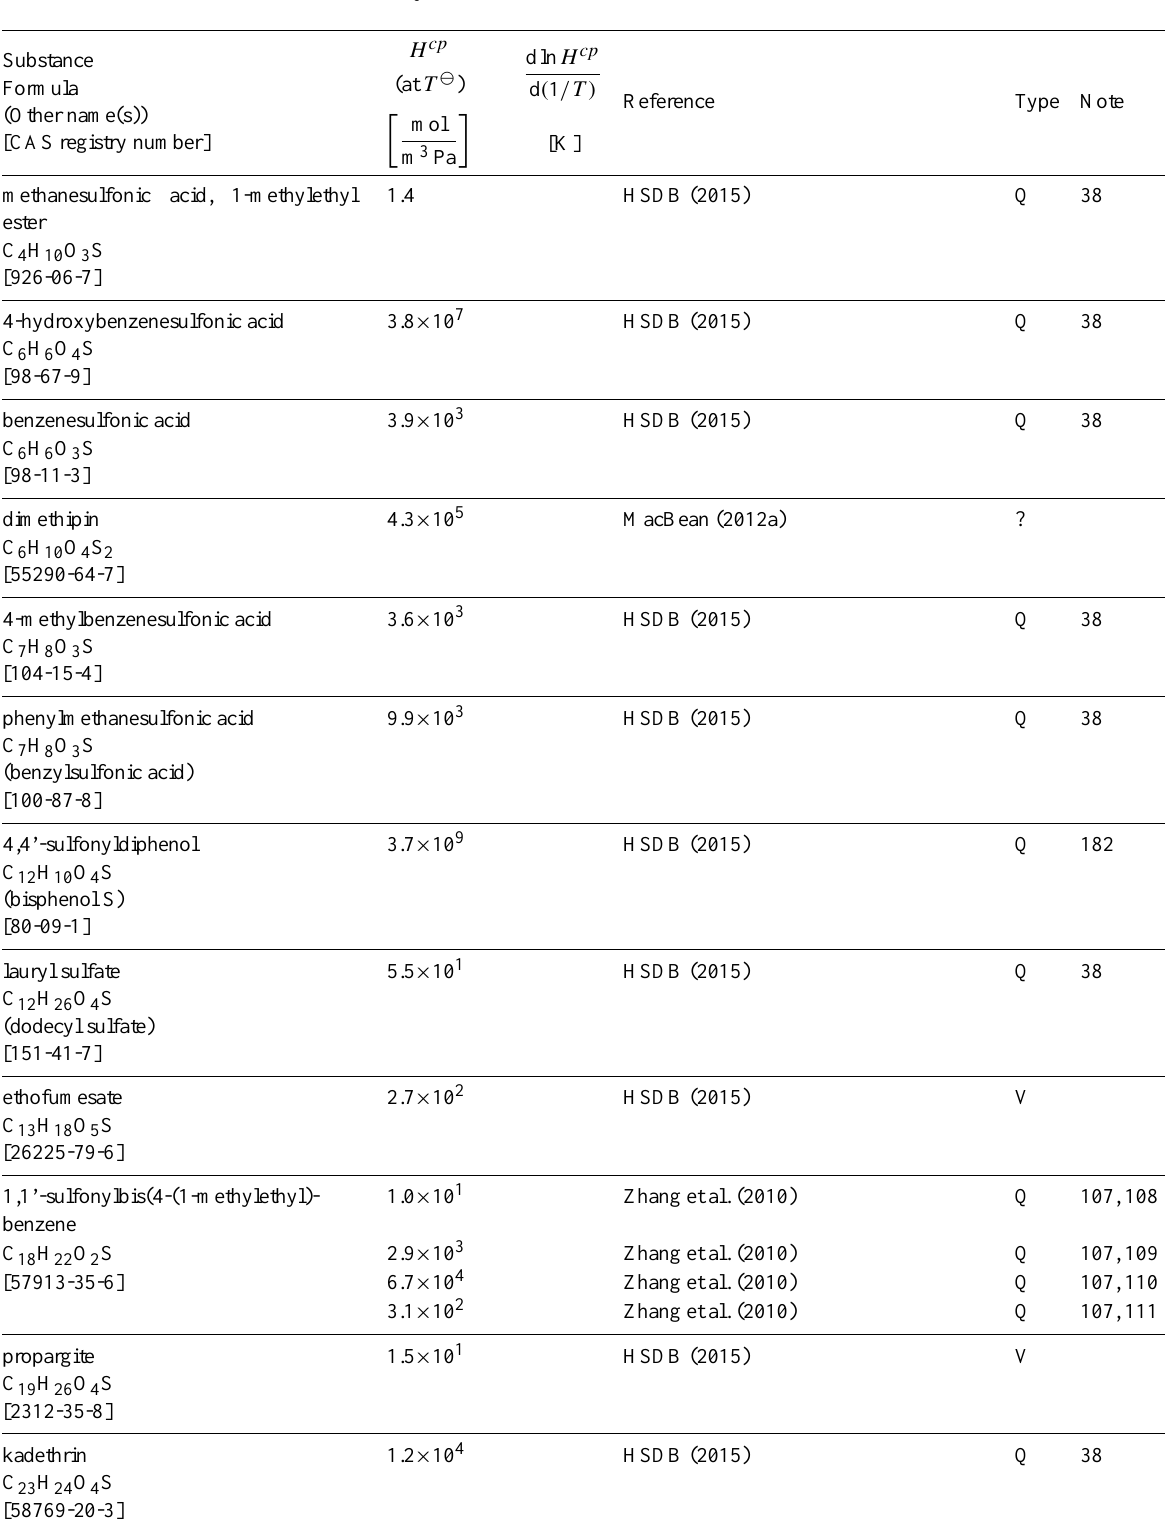
Table 6: Henry’s law constants for water as solvent